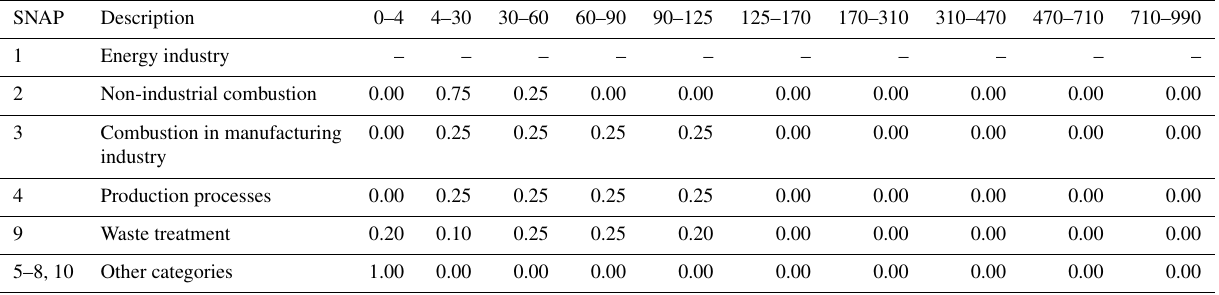
Table 3. Vertical emission profiles for area sources for different SNAP categories as fractions of the total emitted mass per vertical layer. Layers are denoted by their lower and upper limits (meters above ground). Emissions in SNAP 1 are released exclusively from point